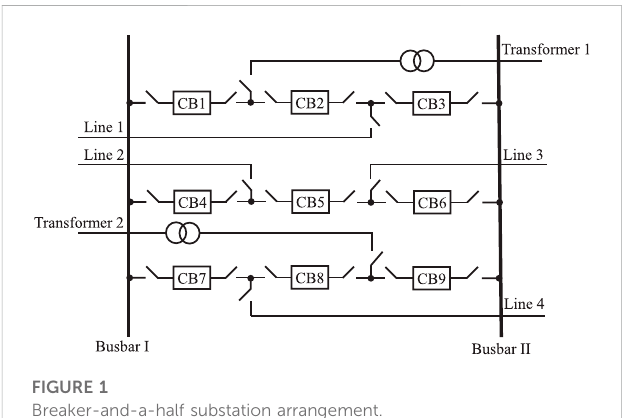
FIGURE 1 Breaker-and-a-half substation